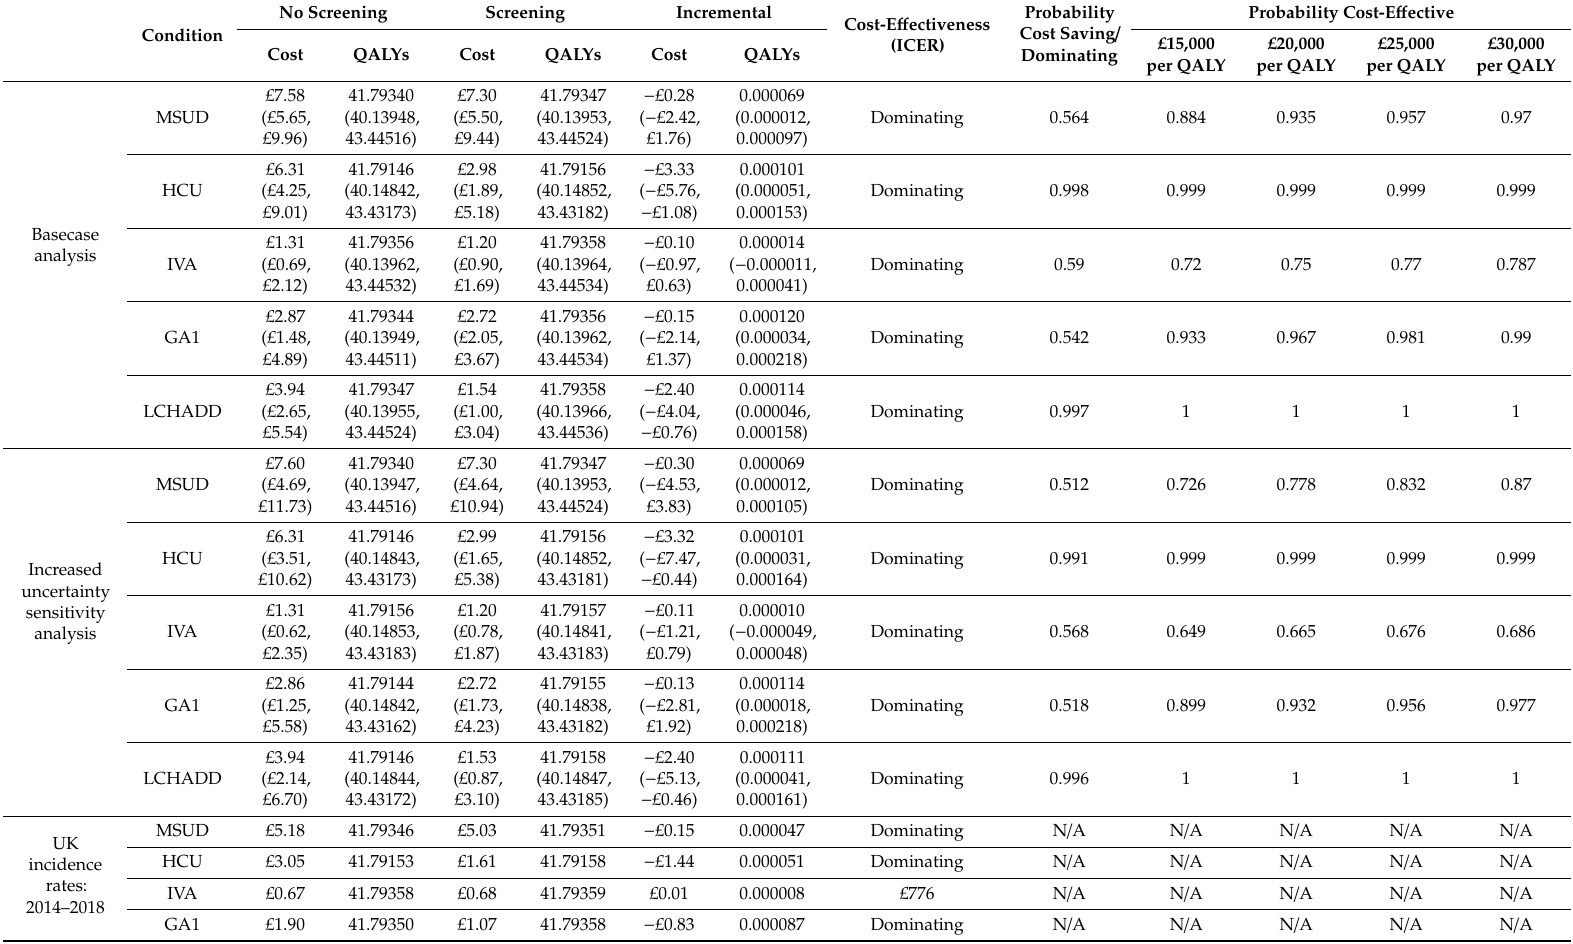
Table 3. Results per baby